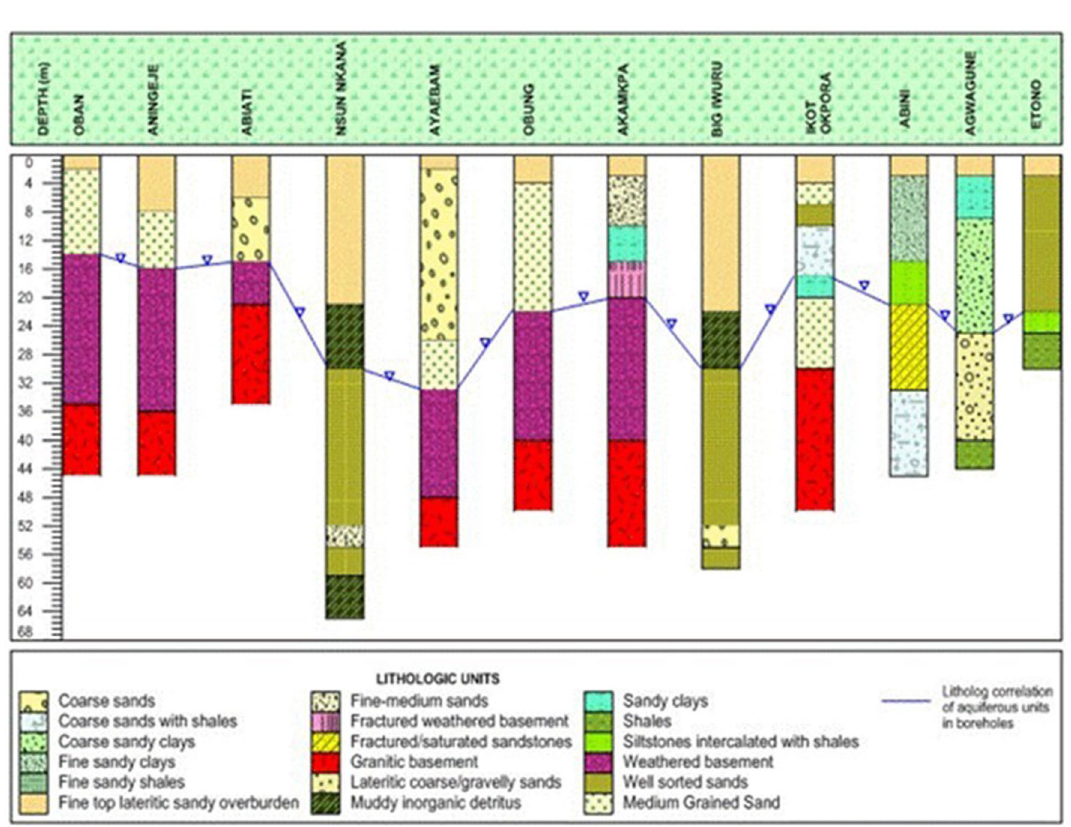
Fig. 6 Lithological correlation cross section of the study